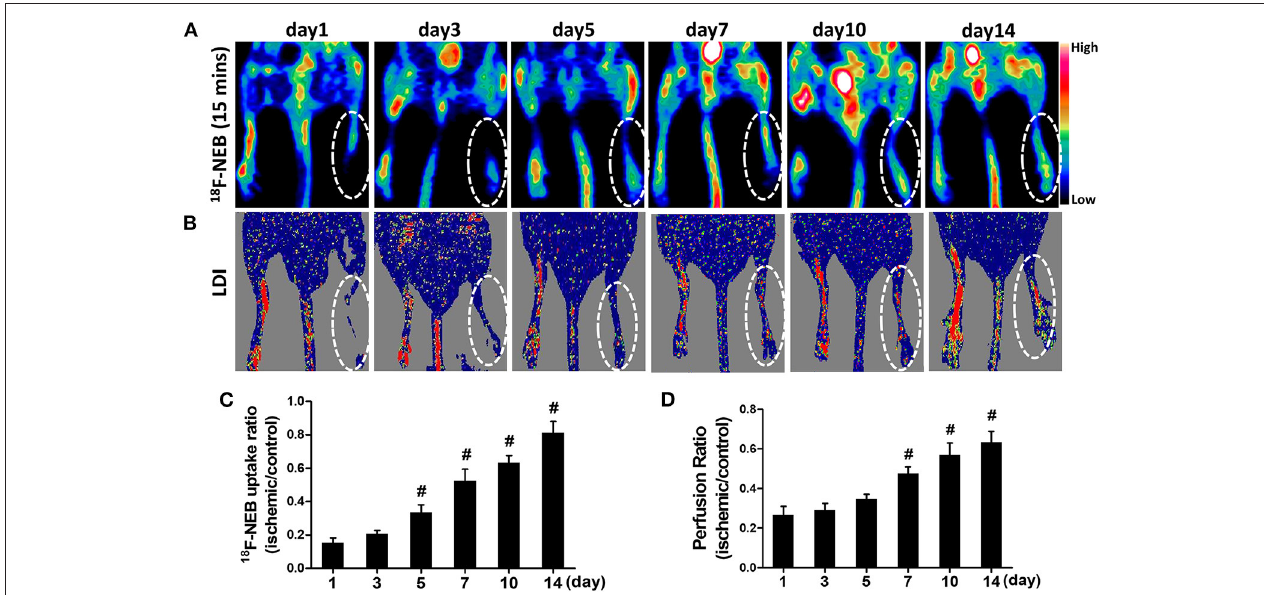
FIGURE 3 | Gradual recovery of blood perfusion was detected by PET imaging at early time (15min) post 18 F-NEB injection (A) , indicating angiogenesis. The similar tendency was also confirmed by serial Laser Doppler imaging (B) . PET imaging and serial Laser Doppler imaging were performed at day 1, day 3, day 5, day 7, day 10 and day 14 post surgery, respectively. Analysis of the 18 F-NEB uptake ratio (ischemic/control hindlimb) by PET (C) and the perfusion ratio (ischemic/control hindlimb) by serial LDI (D) at a serial of time points ( # P < 0.05, vs. day 1).